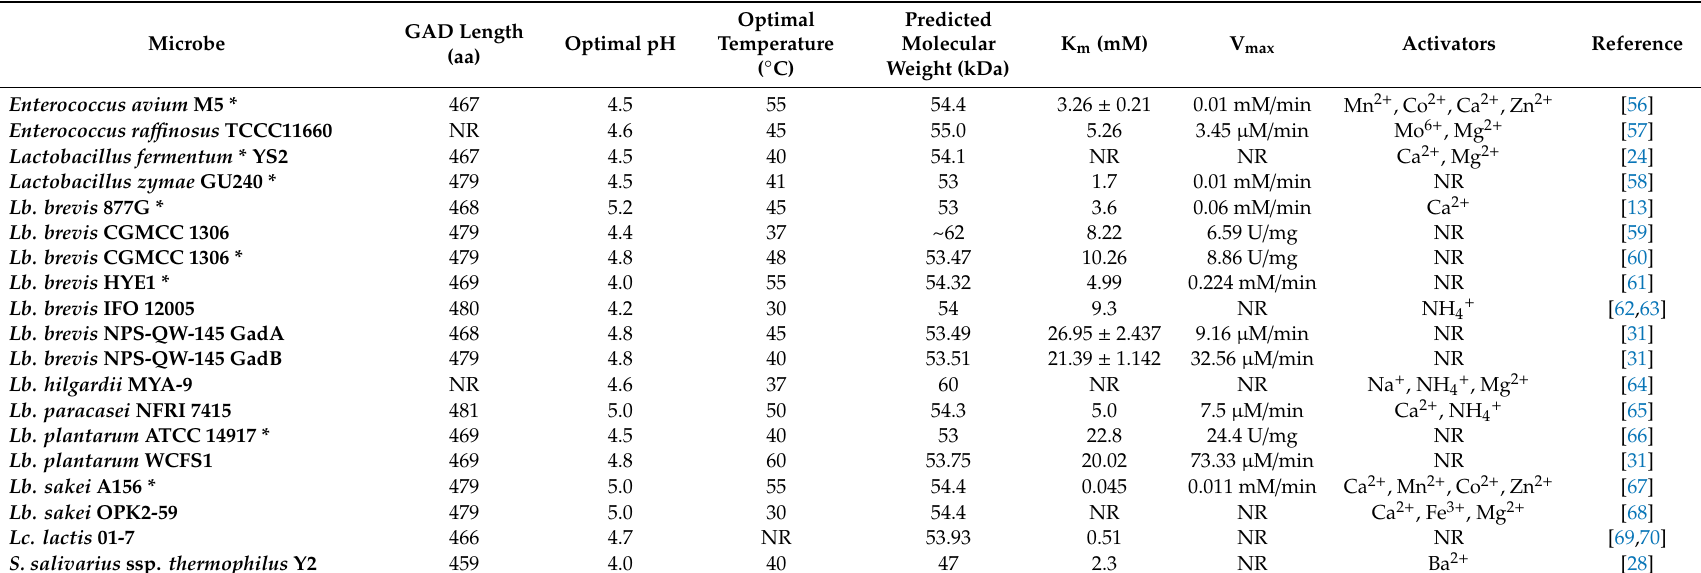
Table 1. The enzymatic properties of GAD from di ff erent